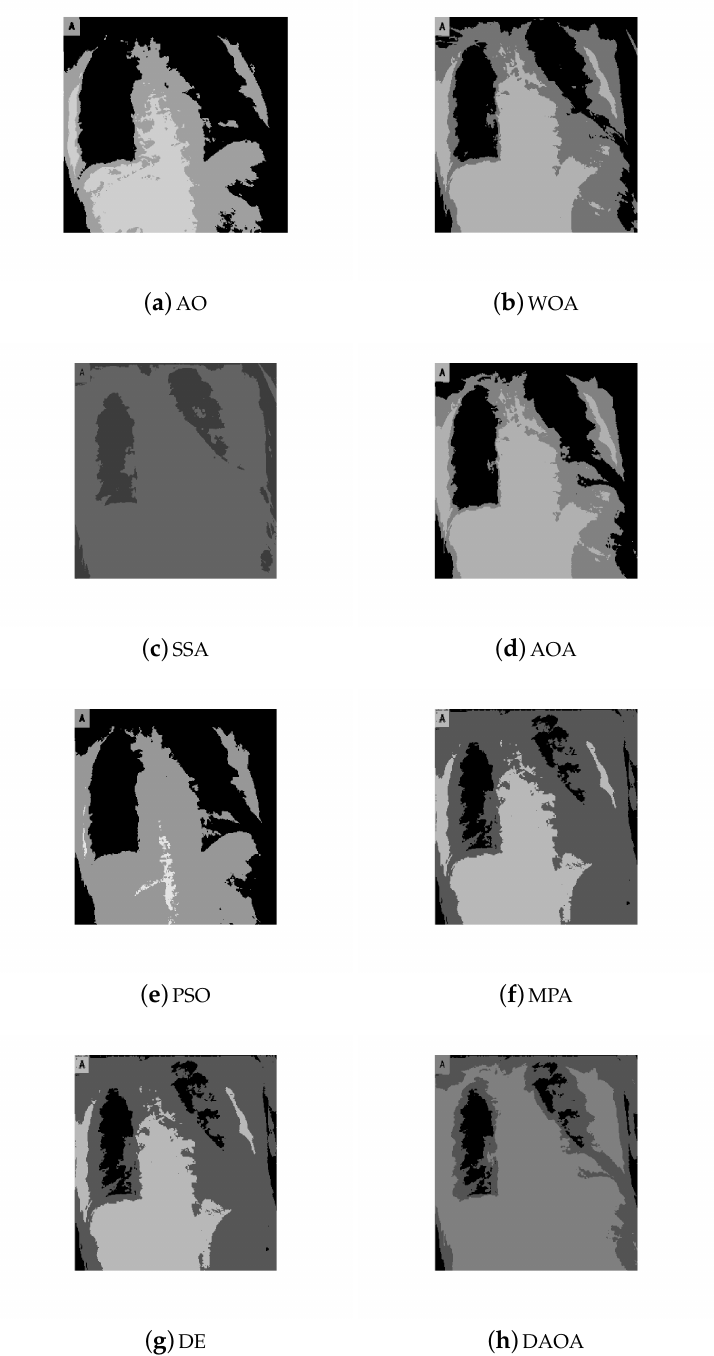
Figure 6. The segmented image (Test 8) by the comparative methods when the threshold value is